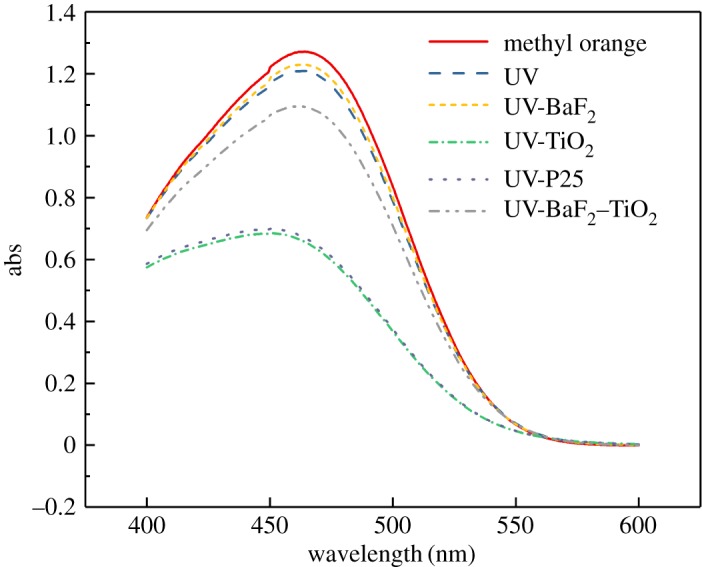
Ultraviolet–visible spectra before and after ultraviolet light irradiation of methyl orange solution with different catalysts (CBaF2, CTiO2, CP25: 1 g l−1; C0.35-BaF2–TiO2: 1.35 g l−1).